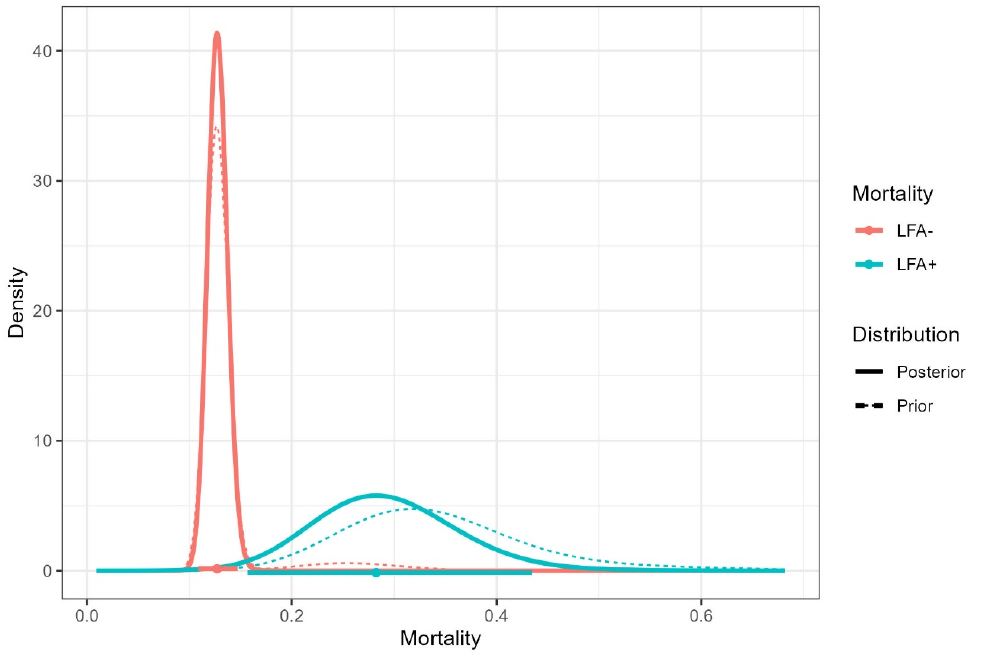
Figure 4. Prior and posterior densities of the mortality proportion with estimated prevalences and HPD credible intervals for positive and negative LFA groups .